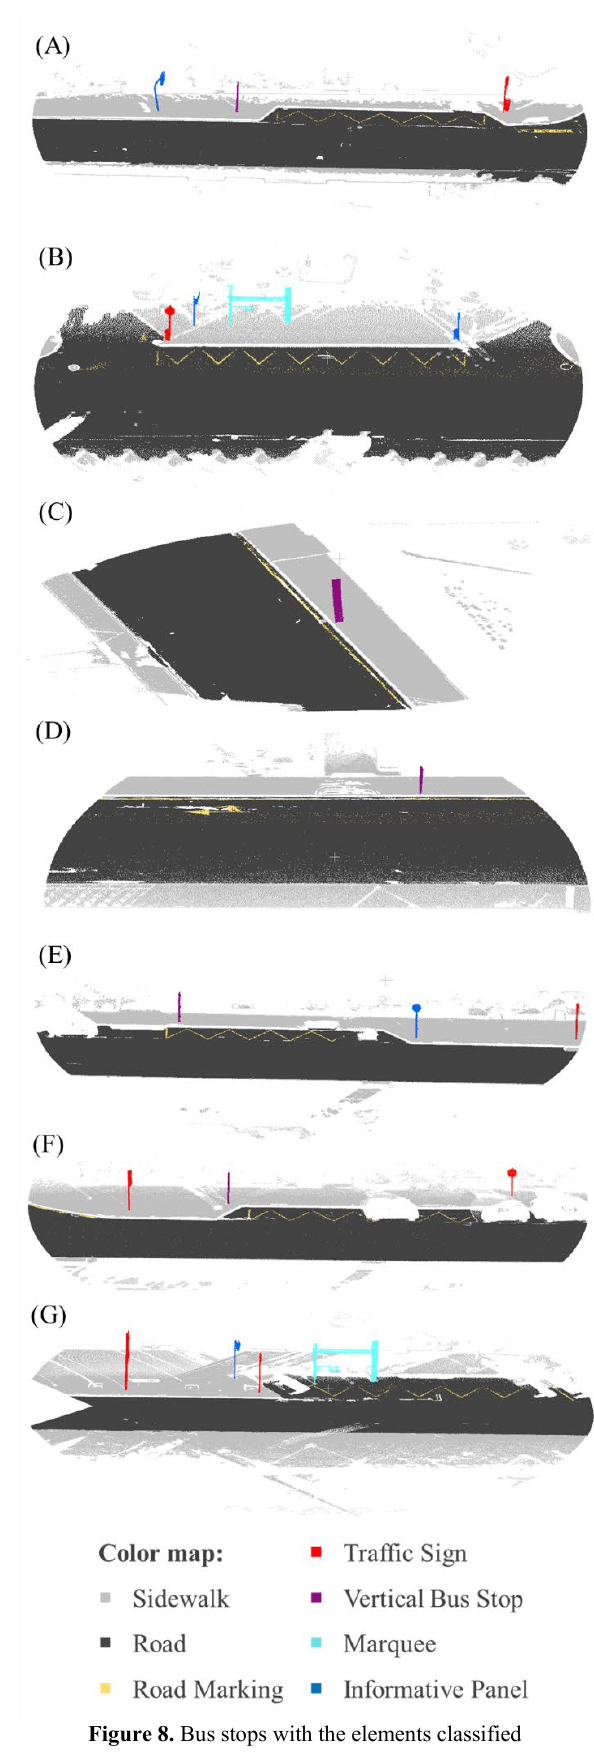
Figure 8. Bus stops with the elements